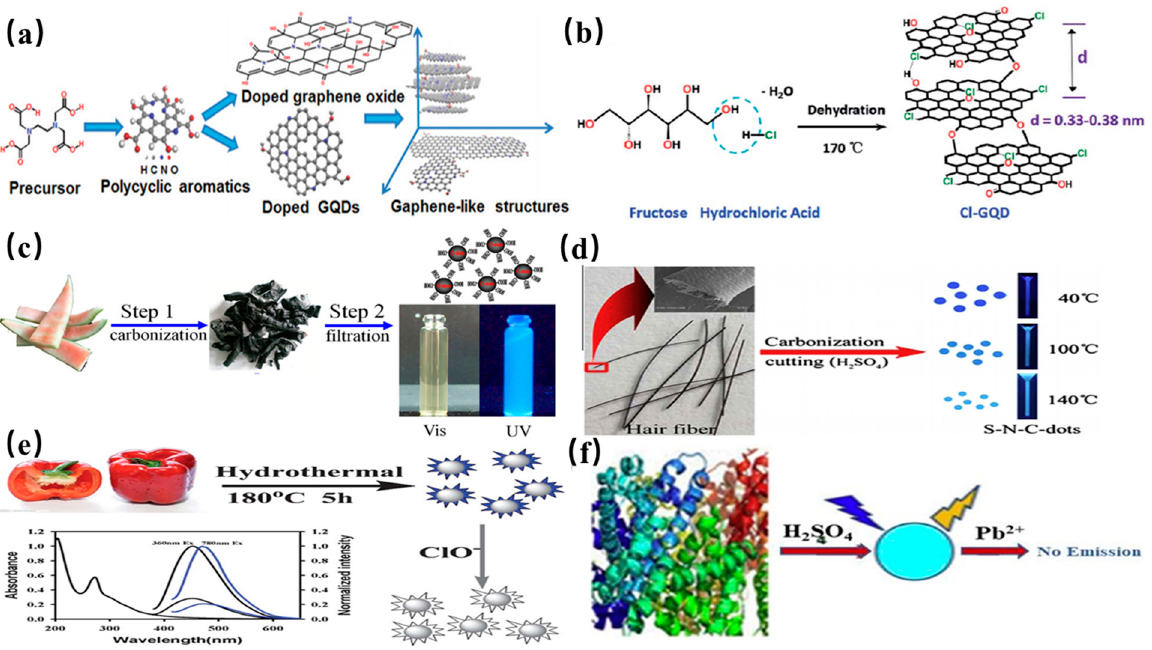
Figure 8. Schematic illustration of ( a ) Preparation of GQDs derived from EDTA [104]. Copyright 2015, Royal Society of Chemistry. ( b ) the preparation of Cl-GQDs from fructose and HCl [105]. Copyright 2013, Royal Society of Chemistry. ( c ) Synthesis of the water-soluble CQDs from watermelon peel [106]. Copyright 2012, Elsevier. ( d ) Formation procedure of the CQDs from hair fiber [109]. Copyright 2013, Elsevier. ( e ) Preparation of the fluorescent CDs from low-cost red pepper [110]. Copyright 2013, Royal Society of Chemistry. ( f ) Heavy metal ion (Pb (II)) detection by CQD [111]. Copyright 2013, Elsevier.